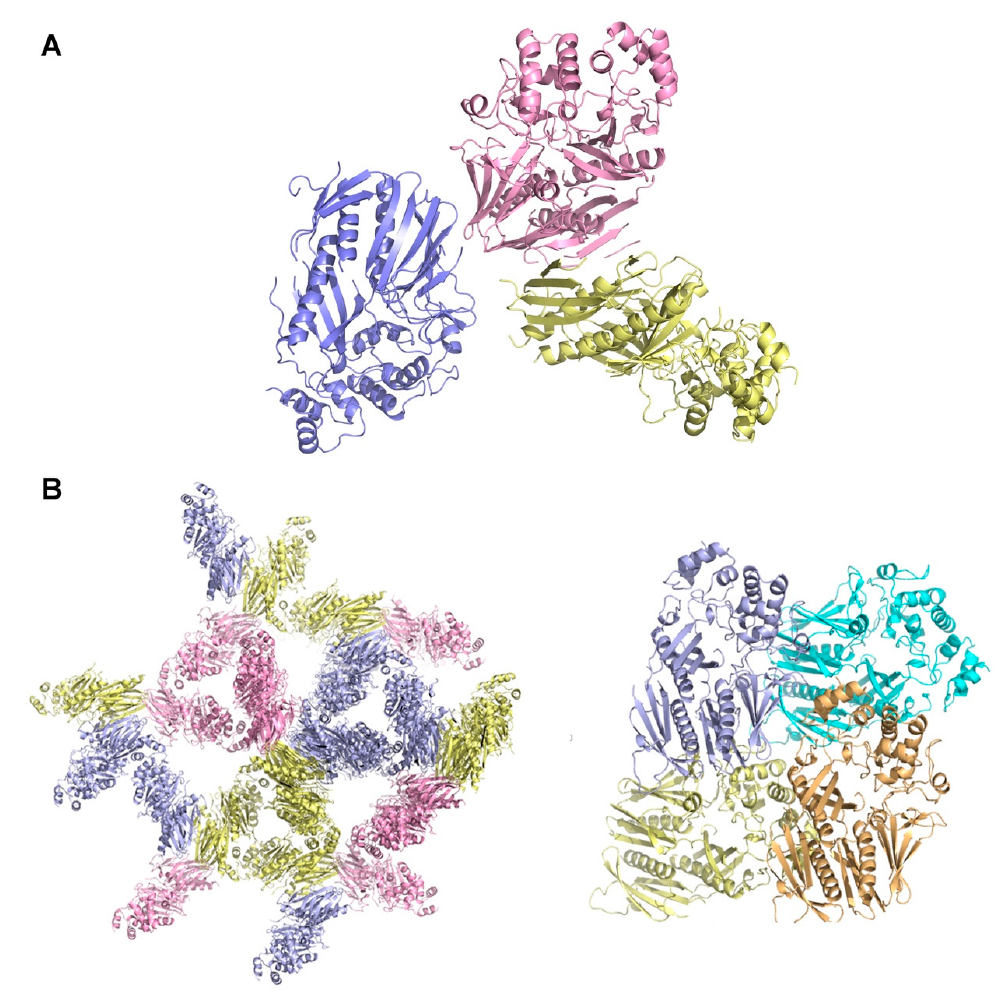
Figure 3. Packing of the complex molecules in the two di ff erent lattices. ( A ) Crystal structure of the XcpVWX ternary complex (PDB ID: 6UTU). ( B ) Spatial arrangement of the XcpVWX complex molecules in the P3 hexagonal lattice (left panel) and the P2 1 2 1 2 1 orthorhombic lattice (right panel). The chuck-like P3 hexagonal crystals show a triangular packing pattern in the lattice. The three molecules in each asymmetric unit (ASU; colored yellow, blue, and pink, respectively) form triangles with the symmetry molecules in the lattice. The compactly packed orthorhombic lattice by XcpVWX molecules is observed in the rod-like crystals (PDB ID: 5VTM). The complex molecules associate with symmetry molecules tightly in this type of lattice. There is only one molecule in each